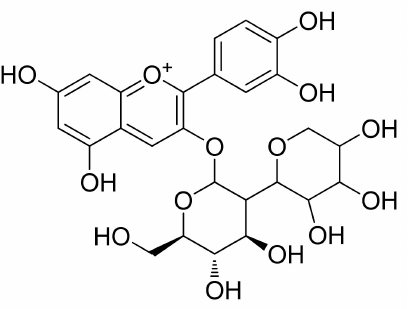
Figure 10. Chemical structure of cyanidin-3-O-(2”0-O-xylosyl)-glucoside. Lycium ruthenicum